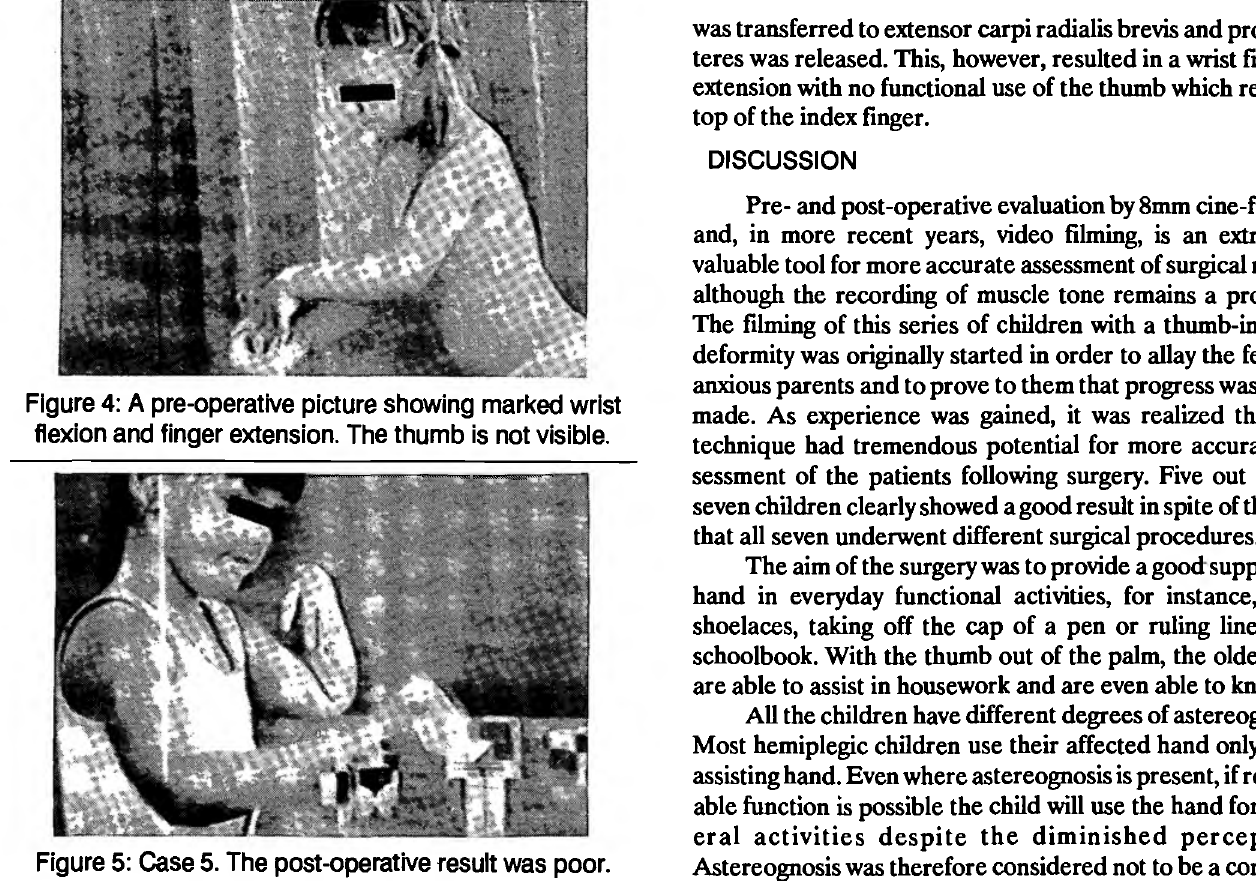
Figure 5: Case 5. The post-operative result was